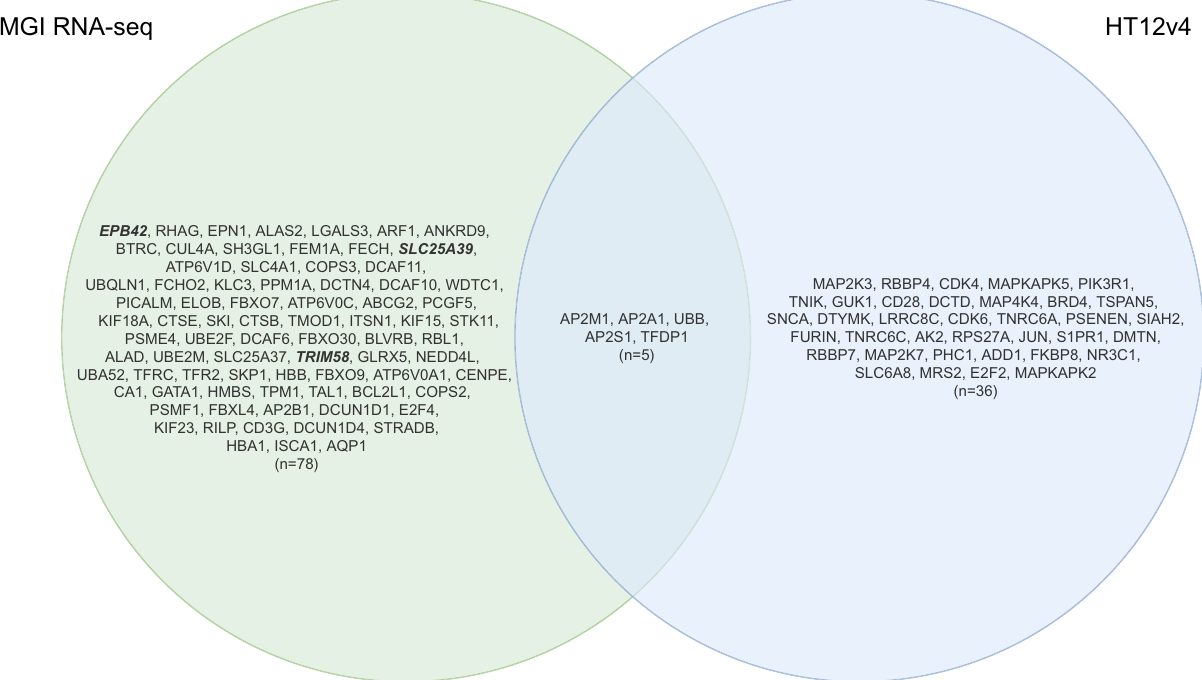
Figure 5. One hundred and nineteen genes confirmed following DGE, GSEA and Reactome analyses across the MGI RNA-seq and HT12v4 BeadChip platforms. EPB42 , SLC25A39 and TRIM58 currently with no entries found in Reactome are highlighted in italics/bold. The diagram was drawn using the online open source tool, draw.io (v15.0.4; https:// github. com/ jgraph/